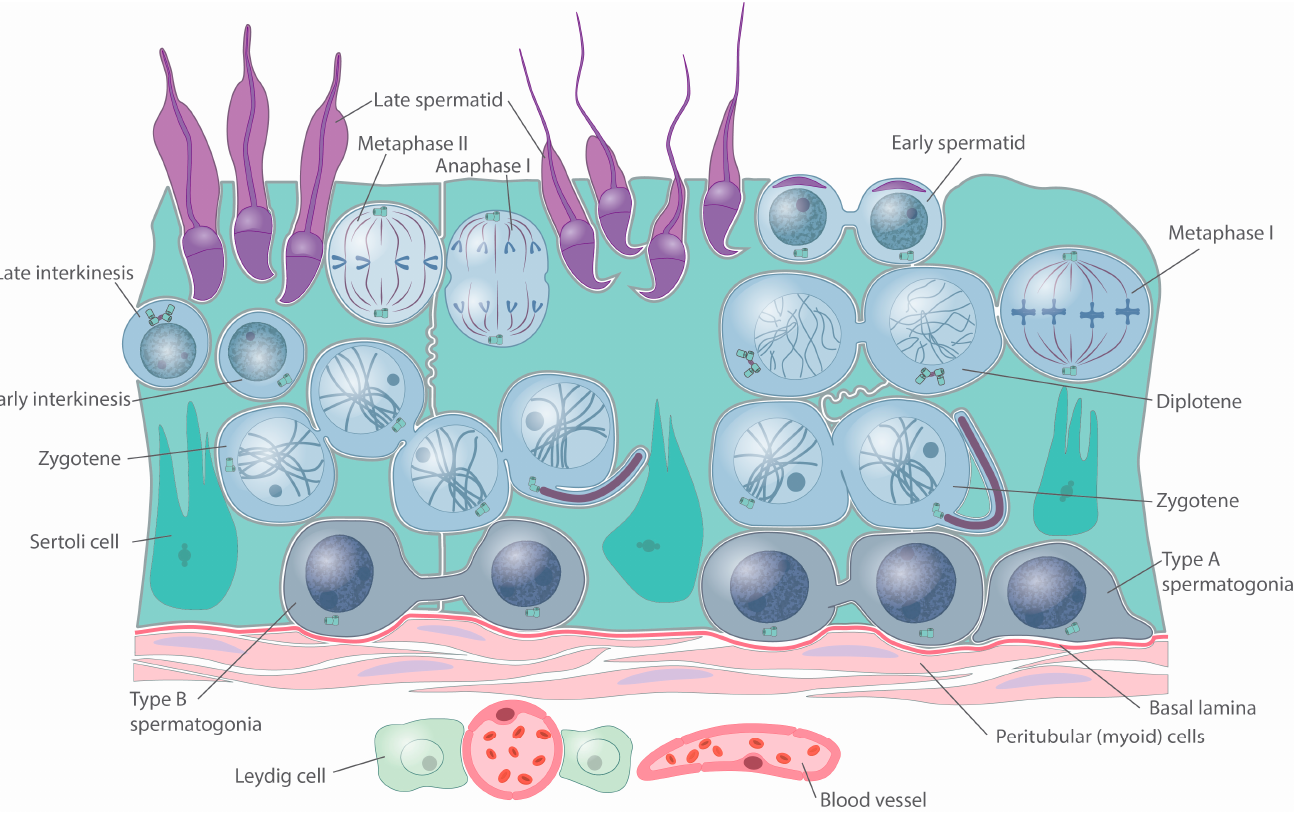
Figure 9. Schematic representation of the seminiferous epithelium with cyst monociliation. Scheme represents spermatogonia (dark grey), spermatocytes (grey), and spermatids (purple) embedded on the cytoplasm of Sertoli cells (turquoise). Centrosomes are indicated for spermatogonia and spermatocytes. Cilia are represented in one of the zygotenes of a cyst of primary spermatocytes. Peritubular and interstitial compartments are represented, indicating the position of myoid cells, Leydig cells, and blood vessels.